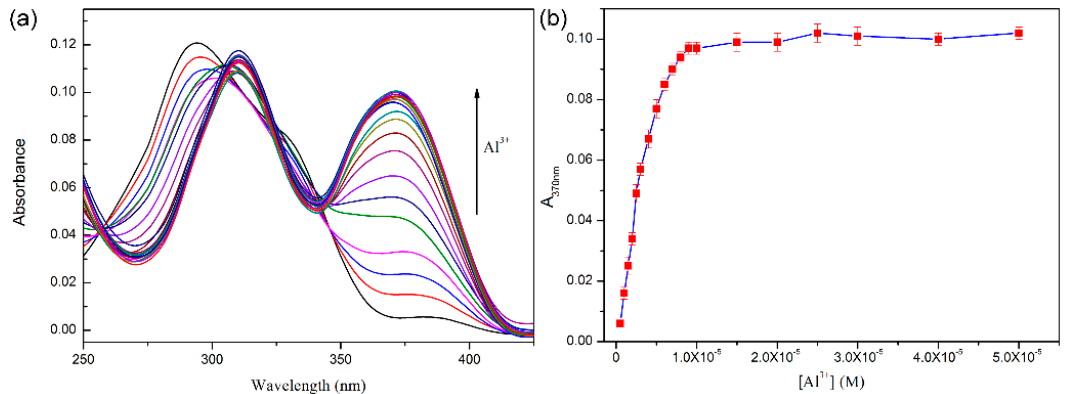
Figure 2. ( a ) UV-Vis absorption spectra of PEGBAB (10 μ M) with the increasing concentration of Al 3+ (0–50 μ M) in aqueous solution. ( b ) Plot of absorption intensity at 370 nm against the concentration of Al 3+ .